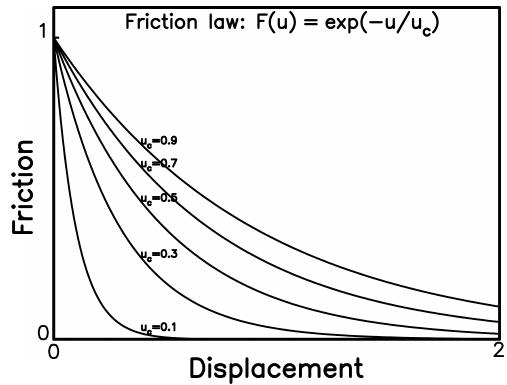
Figure 3. The variations in friction force with displacement for F(u) = exp ( − u/u c ) when u c = 0 . 1, 0.3, 0.5, 0.7, and 0.9m (fol- lowing Wang,